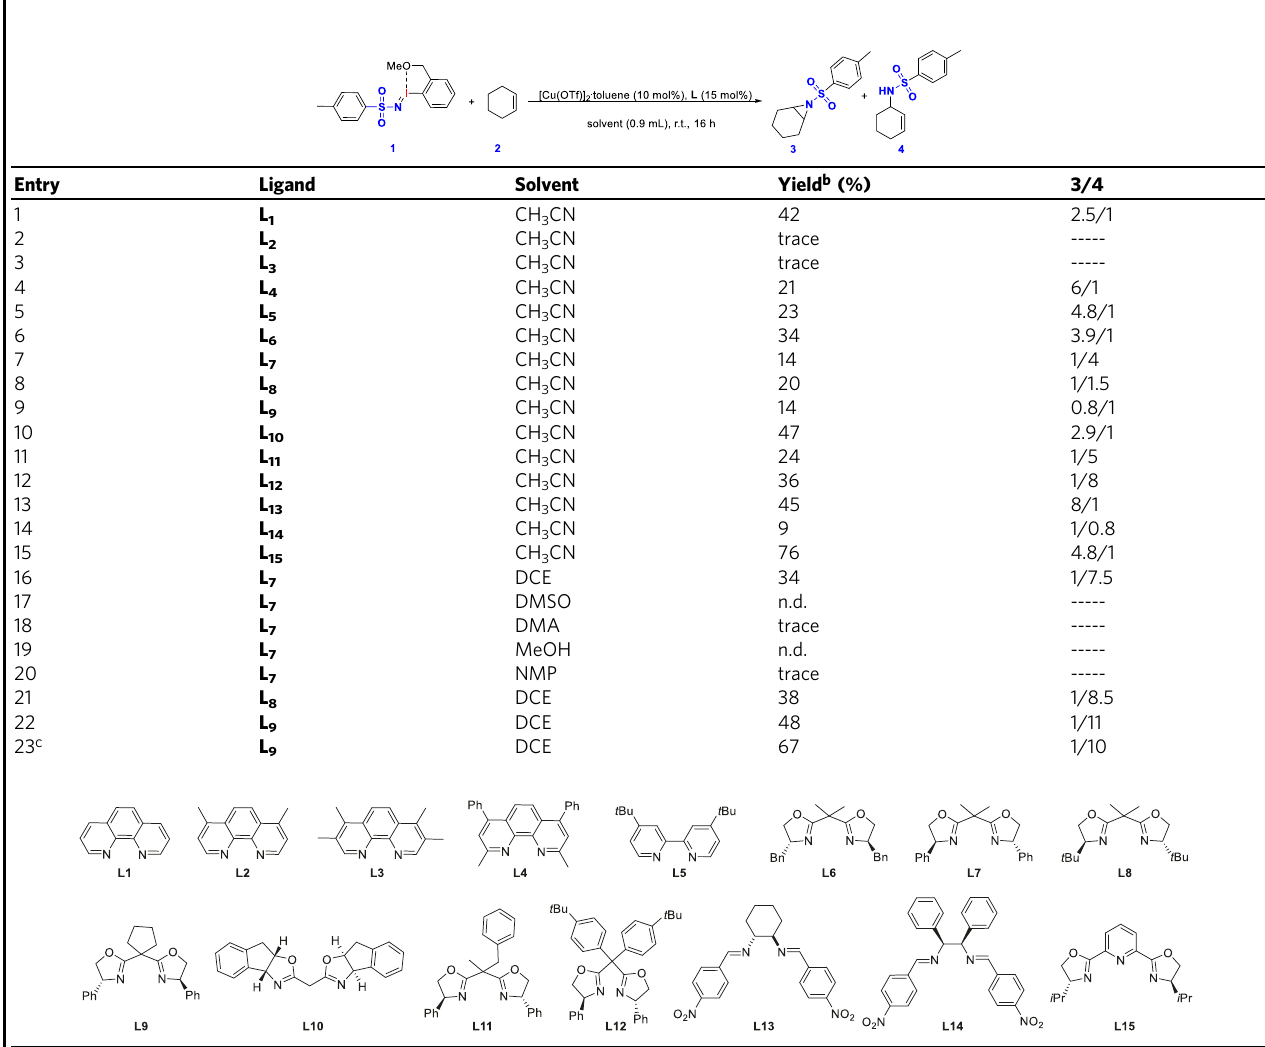
Table 2 Optimization of the reaction conditions for copper-catalyzed C – H amidation a,b,d .